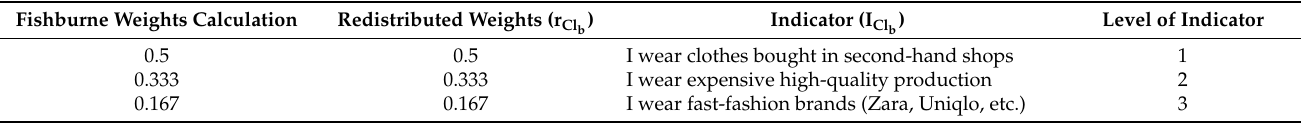
Table 32. Reasoning indicators for buying habits.